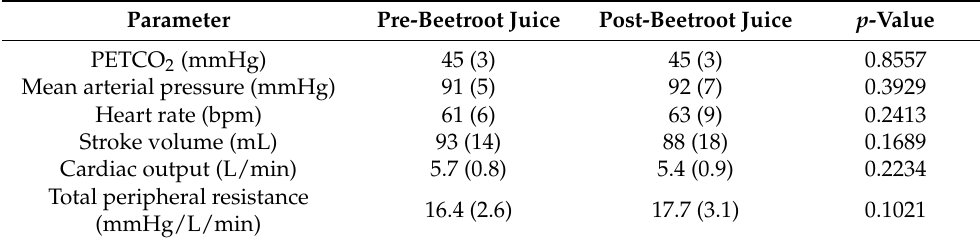
Table 1. Effect of beetroot juice consumption during room air